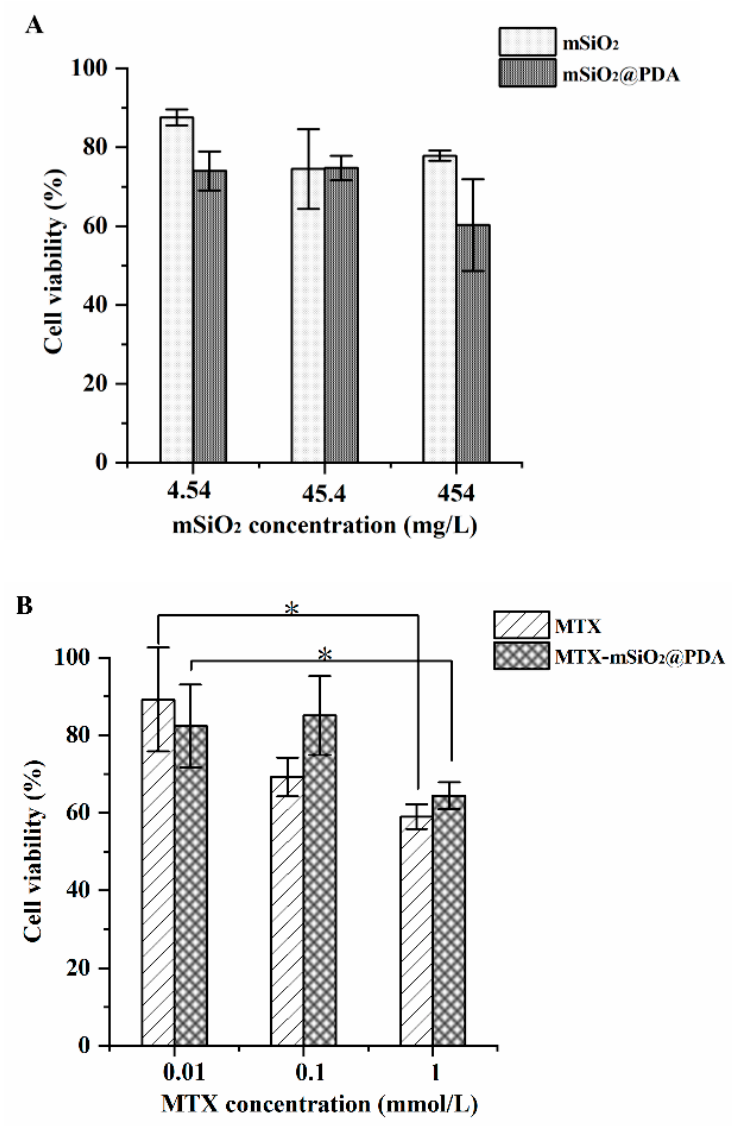
Figure 3. In vitro antiproliferative activities of mSiO 2 , mSiO 2 @PDA, MTX, and MTX-mSiO 2 @PDA. Cytotoxicity of ( A ) mSiO 2 and mSiO 2 @PDA, ( B ) MTX and MTX-mSiO 2 @PDA in RAW264.7 cells. Data are shown as mean ± SD (n = 3, paired-samples t -test * p < 0.05).